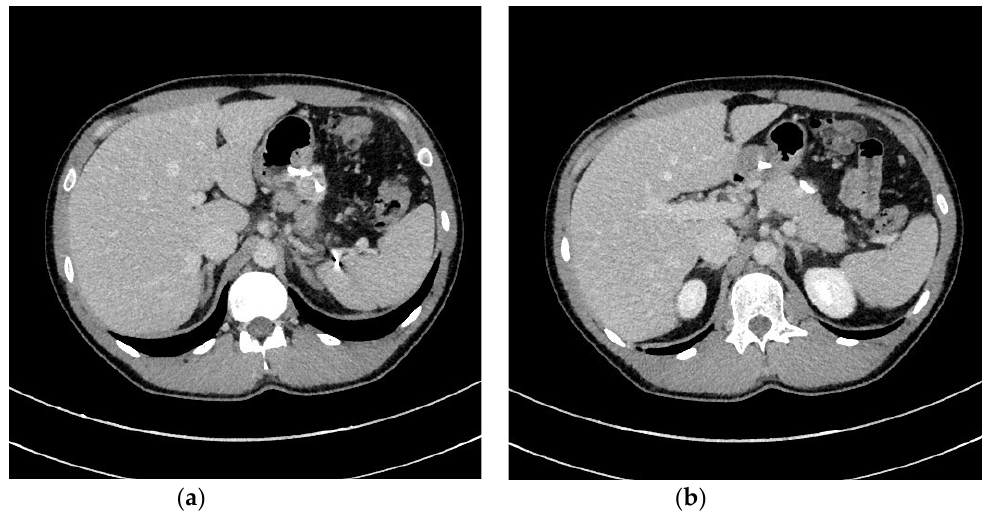
Figure 5. ( a , b ), Abdominal CECT was obtained after 36 days of active transmural drainage (Figure 4a,b). Complete regression of the necrotic collection can be appreciated. In the pancreatic area, transmural stents are visible. CECT, contrast-enhanced computed tomography.